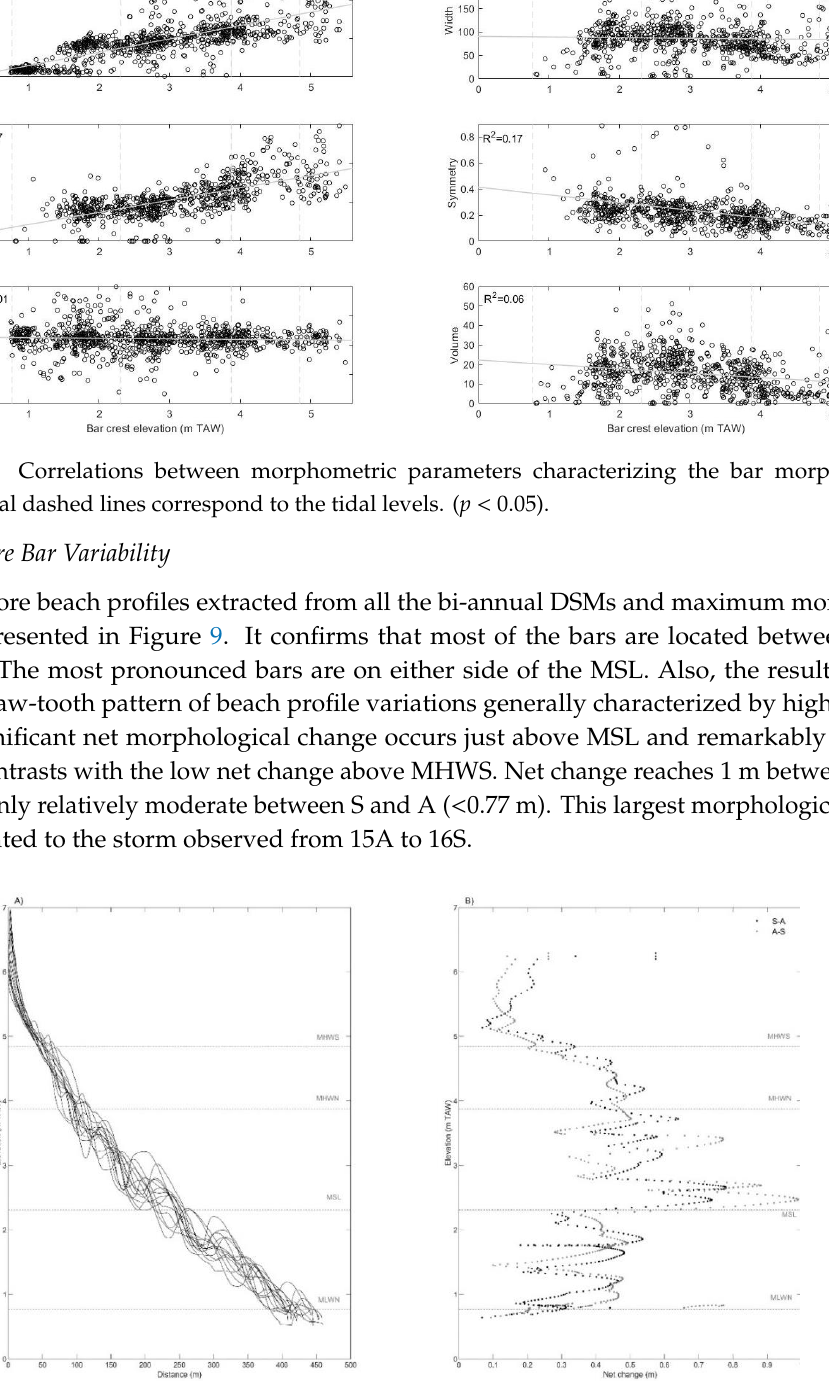
Figure 9. ( A ) Beach profiles for all the surveys from 13S to 19A, and ( B ) cross-shore distribution of maximum net morphological change from spring to autumn (black dots) and from autumn to spring (grey dots) for the entire profile dataset. The horizontal dashed lines correspond to the tidal